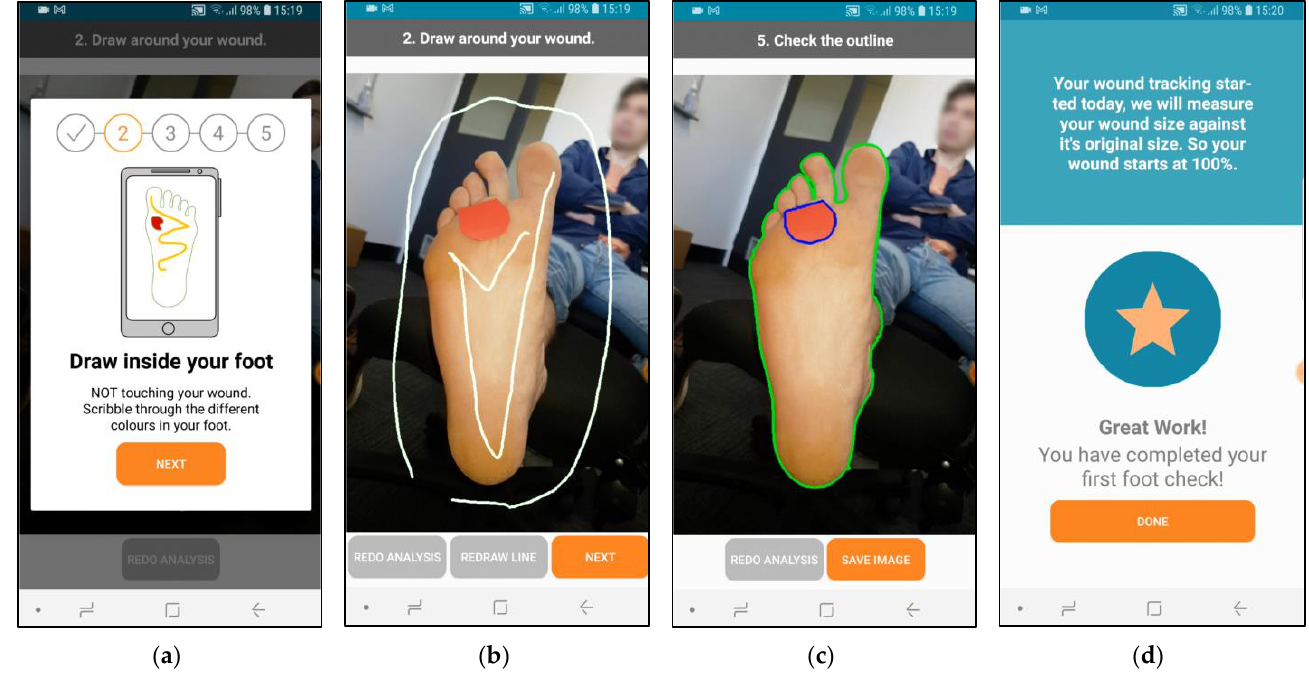
Figure 3. Foot checks involve a five-step process to segment the ulcer from the rest of the foot and the background: ( a , b ) users need to draw a line around the foot, draw inside the foot, zoom in on wound, draw inside the wound, and ( c ) check the outlines around the ulcer and around the foot. If the outlines are inaccurate, users can redraw the lines to get a more accurate result. ( d ) Users receive tailored feedback to encourage monitoring.